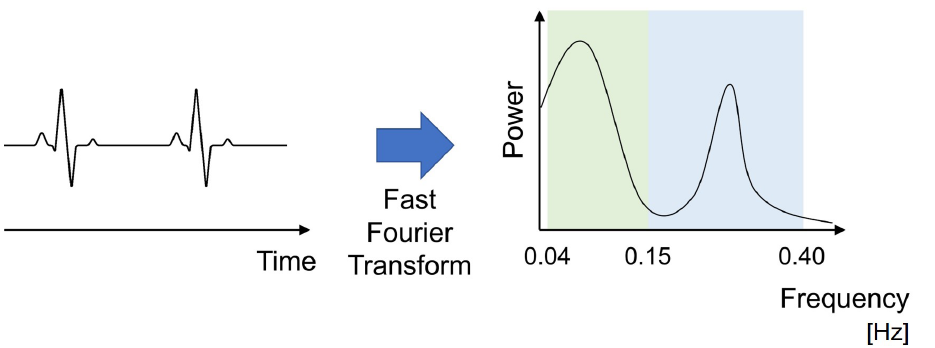
Figure 1. The relation of heartbeat, HF and